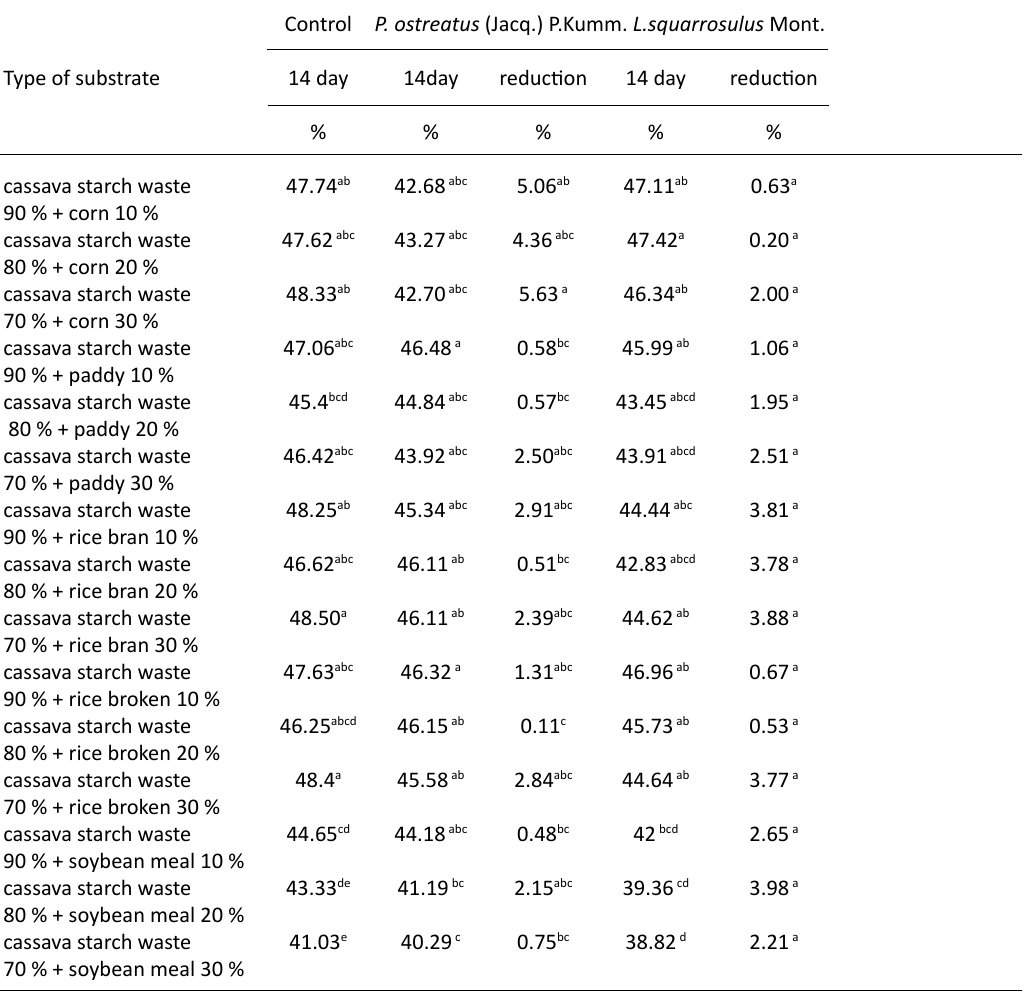
Table 3. Effect of P. ostreatus (Jacq.) P.Kumm. and L. squarrosulus Mont. on carbon percentage content at 14 day